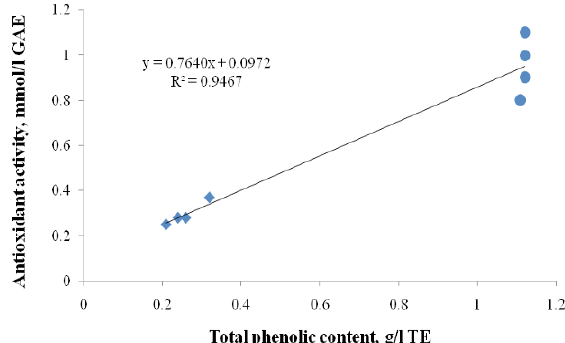
Figure 7. Relationship between the total polyphenolic compounds contents (TPC) and antioxidant activity (TAA) by DPPH method values of SGV and SZW (as an example). ( ♦ ) white wine ( ● ) red